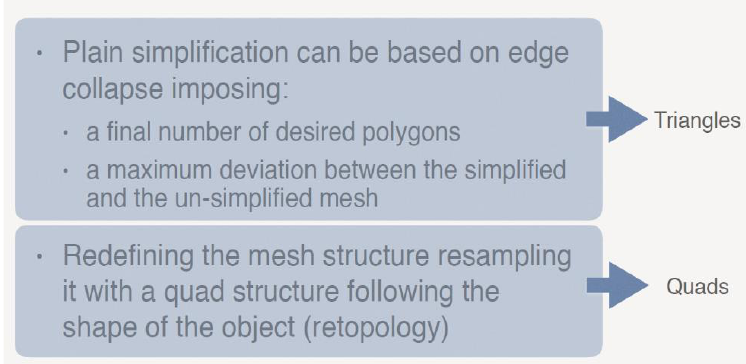
Figure 3. Comparison between the triangular and the retopology simplification.